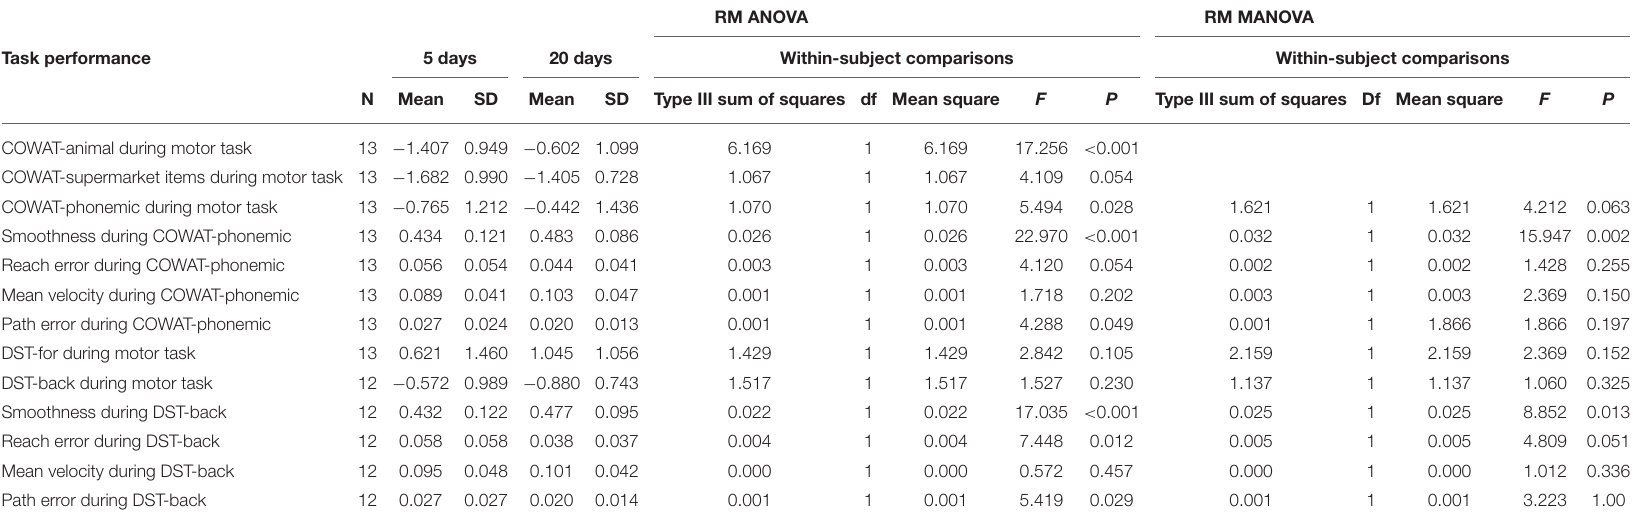
RM ANOVA RM MANOVA Type III sum of squares Df Mean square F P